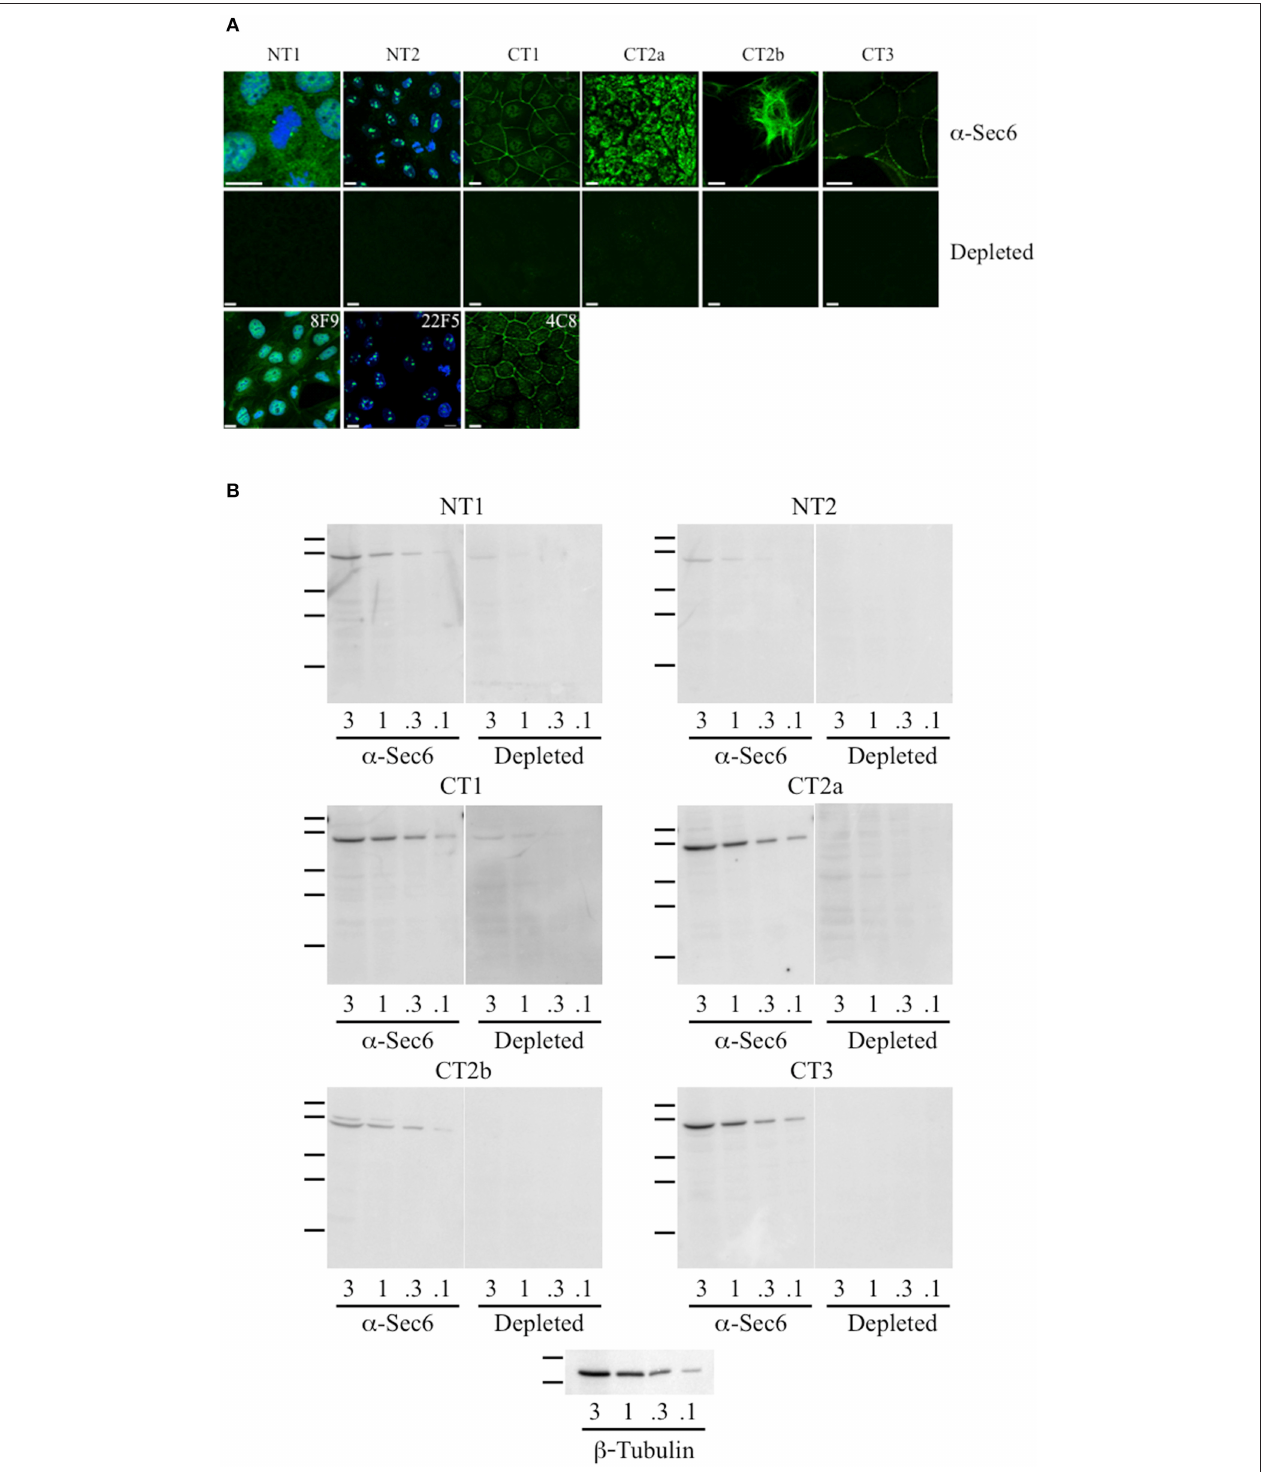
FIGURE 2 | Antibodies to different Sec6 subdomains label distinct subcellular structures. (A) Immunofluorescent labeling of MDCK cells with antibodies to Sec6 NT1 (mAb 13F10), NT2 (mAb 16G4), CT1 (mAb 10C3), CT2a (mAb 3F3), CT2b (mAb 11A2), or CT3 (mAb 8A5) subdomains (“ α -Sec6”) or hybridoma